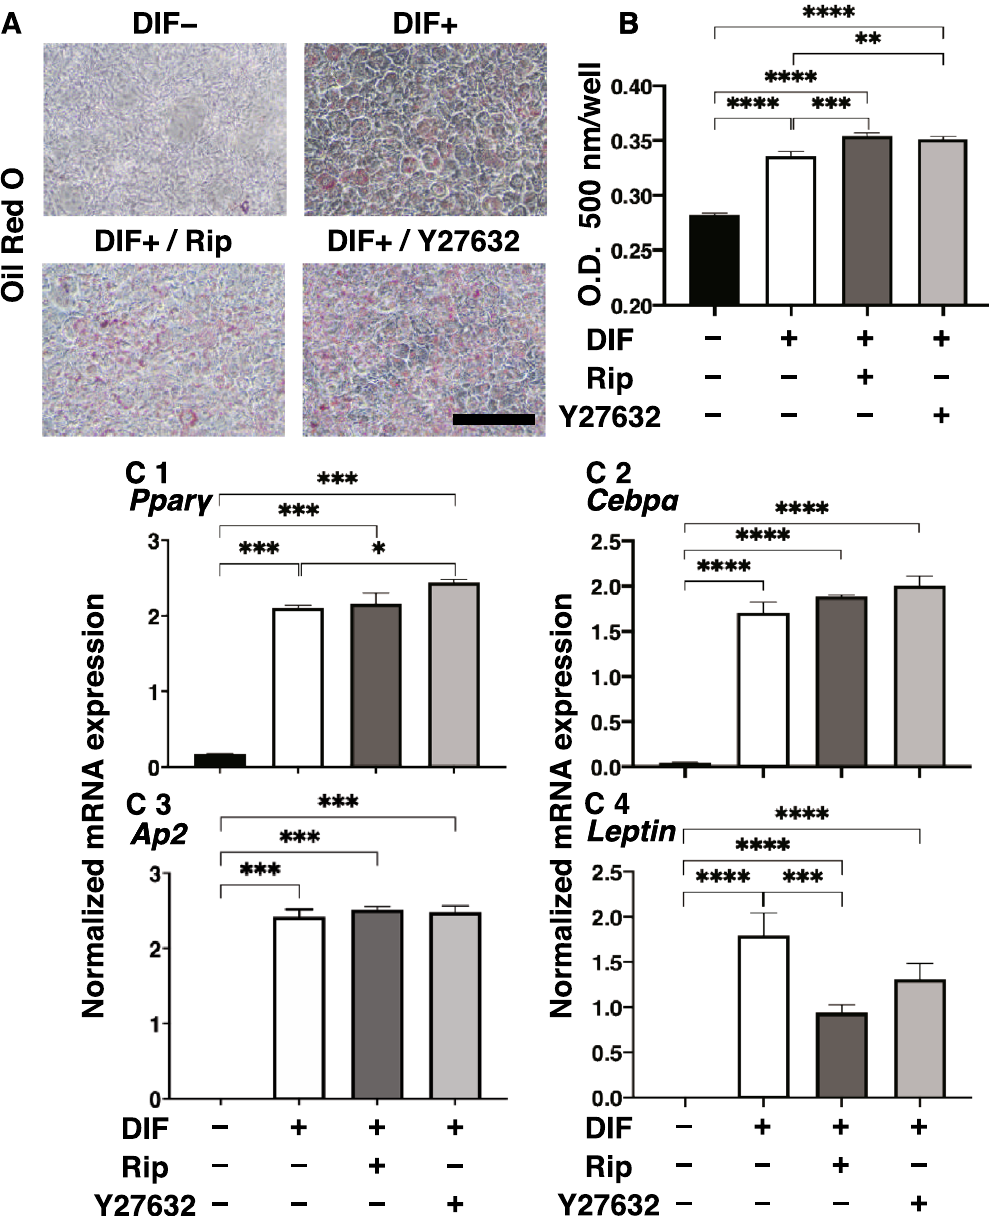
Figure 1. Effects of ROCK-i on adipogenesis of 2D cultured 3T3-L1 cells. 2D cultures of 3T3-L1 cells were performed under several conditions; preadipocytes of 3T3-L1 cells (DIF−) and their adipogenic differentiation (DIF+) with or without 10 µM Ripasudil (Rip) or Y27632. These were stained by Oil Red O ( A , scale bar: 100 μm) and their staining intensities were plotted ( B ). The mRNA expressions of adipogenesis related genes including Pparγ , Cebpa and Leptin under the above conditions were plotted in ( C ) 1–3. All experiments were performed in triplicate using fresh preparations, each consisted of 5 samples. Data are presented as arithmetic means ± standard error of the mean (SEM). * P < 0.05, ** P < 0.01, *** P < 0.005, **** P < 0.001, and other pairs were not statistically significant (ANOVA followed by a Tukey’s multiple comparison